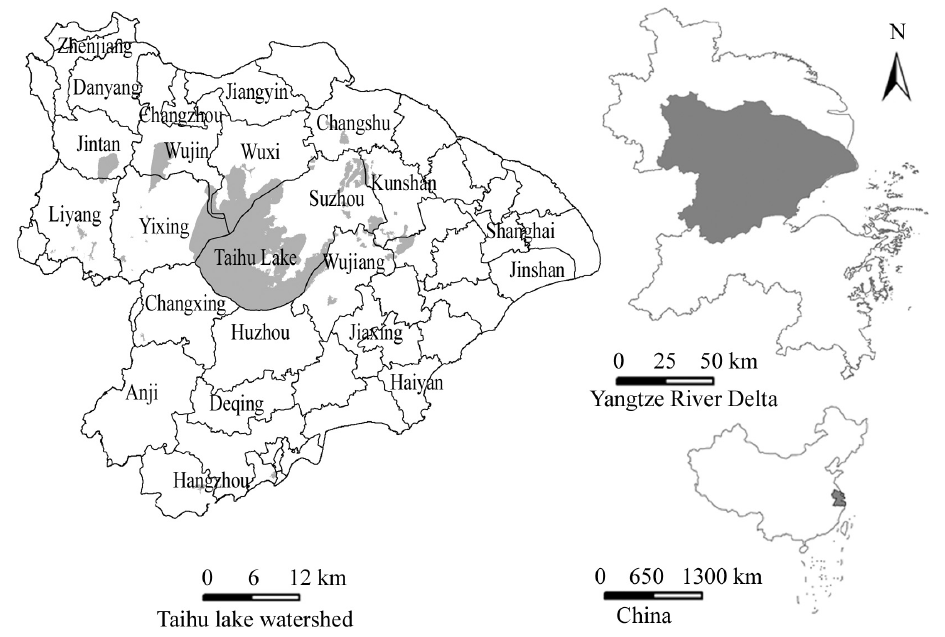
Figure 1. The location of the study